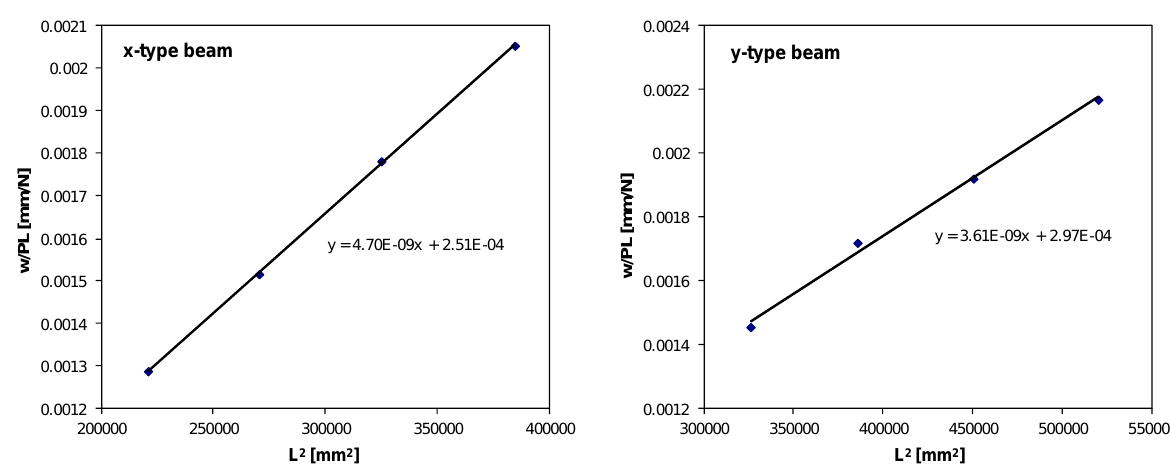
Figure 5: Experimental results of the variable span TPB tests on x- and y-type sandwich beams.